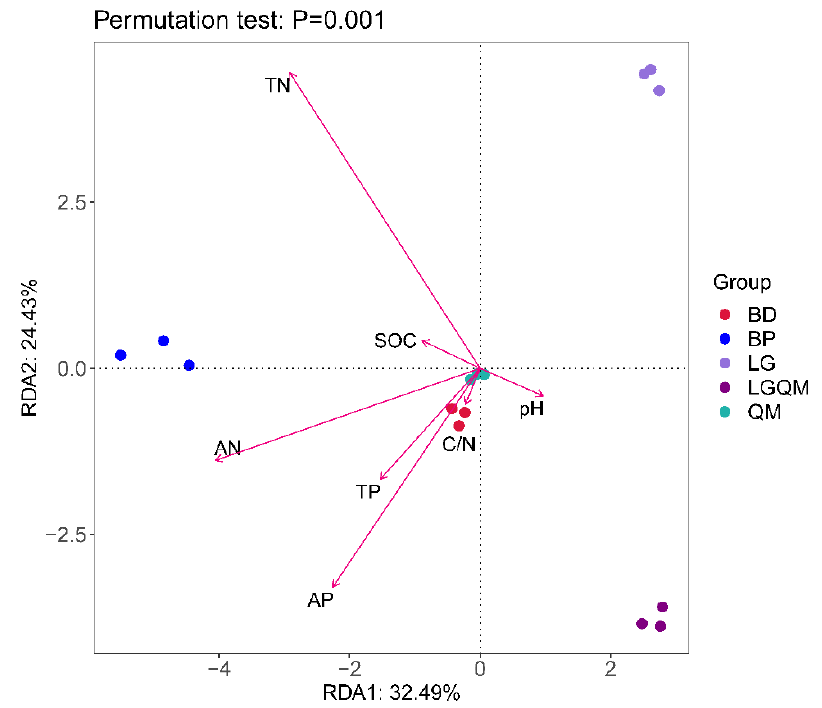
Figure 2. RDA results, including all of the examined soil physicochemical parameters. BD, Betula dahurica forest; BP, Betula platyphylla forest; LG, Larix gmelinii forest; LGQM, Q. mongolica and L. gmelinii mixed forest; QM, Quercus mongolica forest. TN, total nitrogen; SOC, soil organic carbon; TP, total phosphorous; AN, available nitrogen; AP, available phosphorous.